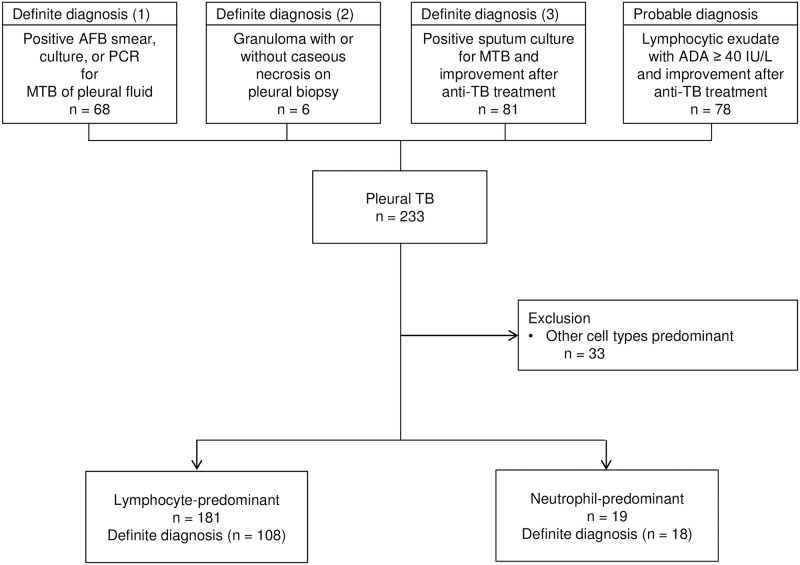
Groupings of study population according to diagnostic criteria and cell type predominance.TB, tuberculosis; AFB, acid-fast bacilli; PCR, polymerase chain reaction; MTB, Mycobacterium tuberculosis; ADA, adenosine deaminase.